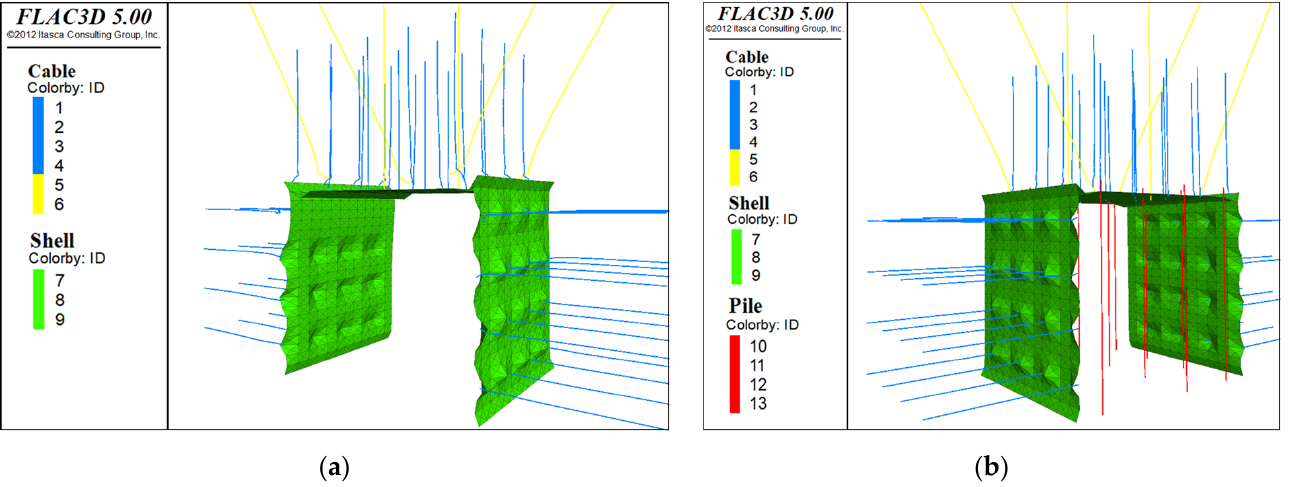
Figure 13. Structural elements analysis of schemes 1 and 2. ( a ) Scheme 1: bolt ‐ mesh ‐ cable support; ( b ) Scheme 2: bolt ‐ mesh ‐ cable and single hydraulic prop support.